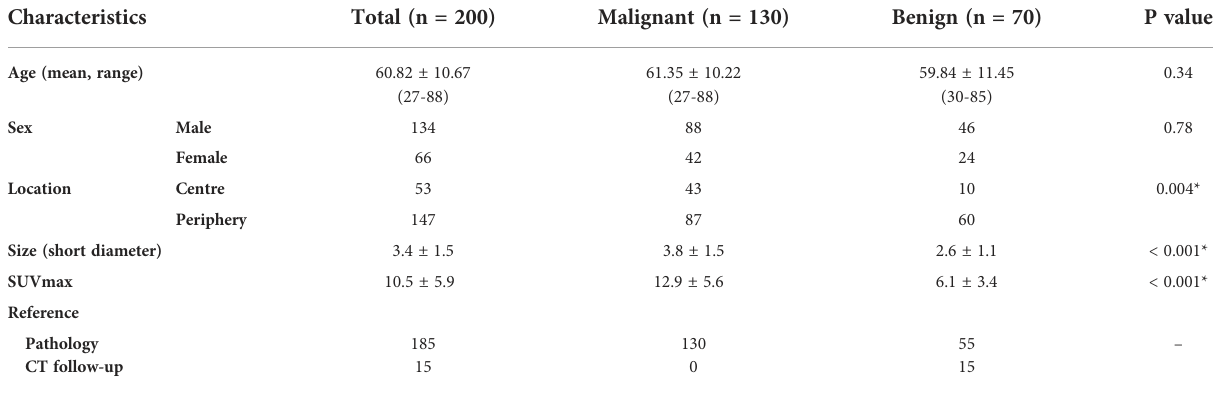
TABLE 1 The characteristics of all patients.